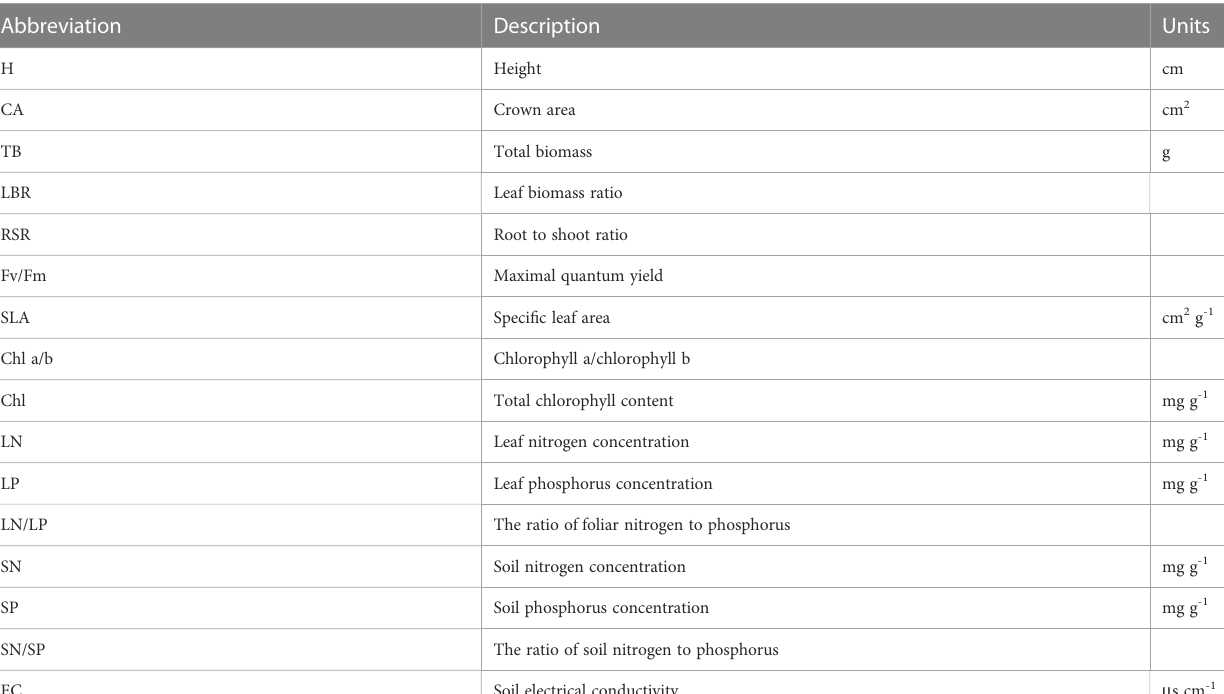
TABLE 1 Descriptions of traits and performance